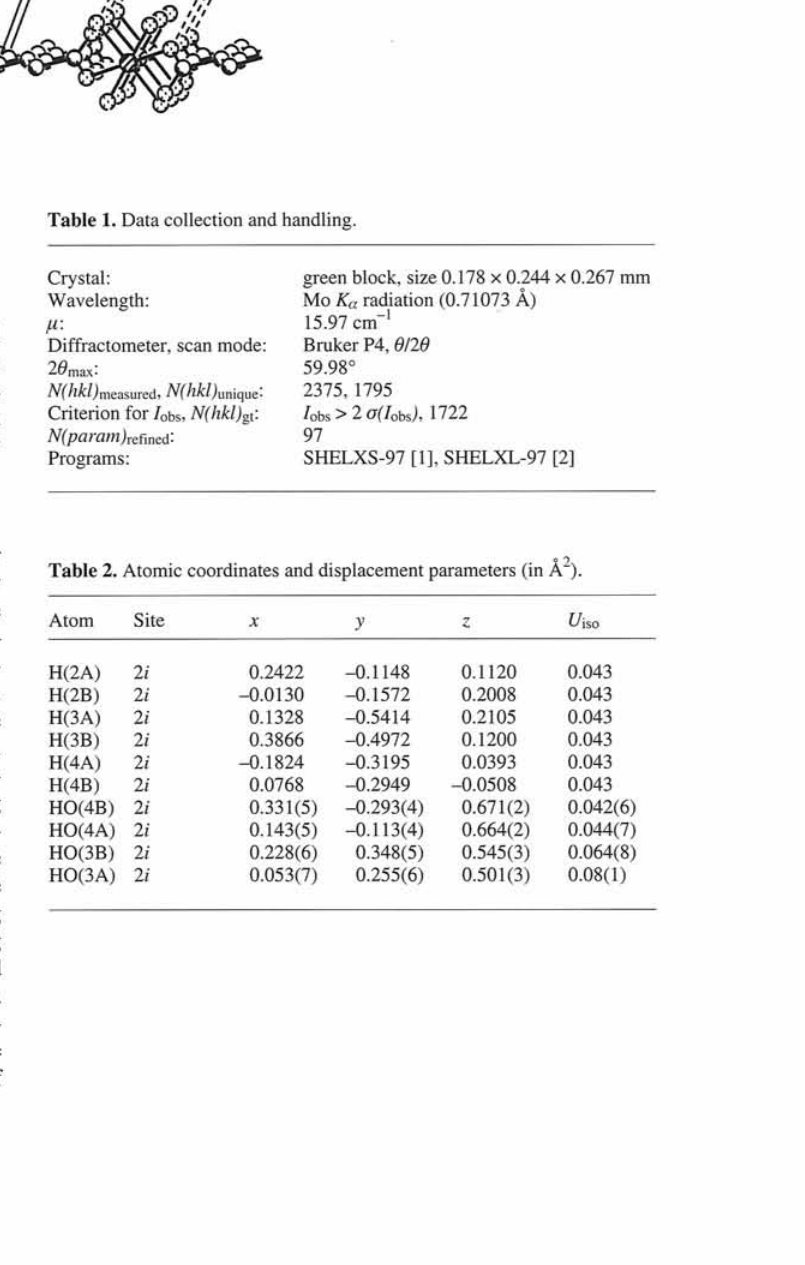
Table 1. Data collection and handling.